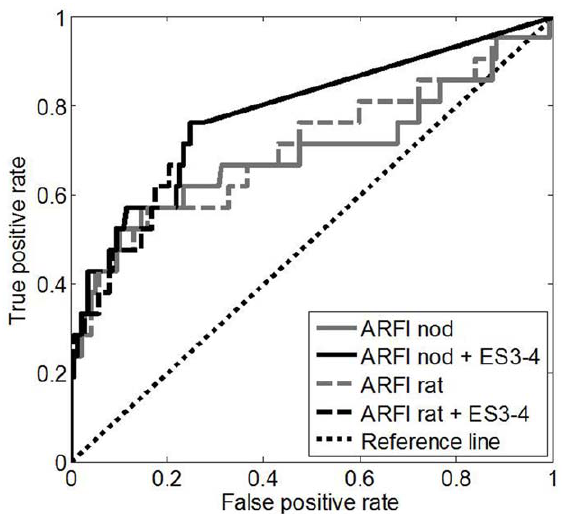
Figure 3. Receiver-operating characteristic (ROC) curves for ARFI-imaging of thyroid nodule (ARFI-nod) and for the ratio of ARFI-imaging of thyroid nodule divided by ARFI-imaging of healthy thyroid tissue (ARFI-rat) for diagnosis of malignant thyroid nodules (AUROC 69% and 71%, respectively) and the ROC curves for the combination of these criteria with Realtime Elastography Score (ES) 3–4 (AUROC 78% and 78%, respec- tively). The improvements with respect to ARFI alone were not significant (p=0.18 for ARFI-nod, p . 0.20 for ARFI-rat), analogously the improvements with respect to ES alone were not significant (p . 0.20 in both cases).